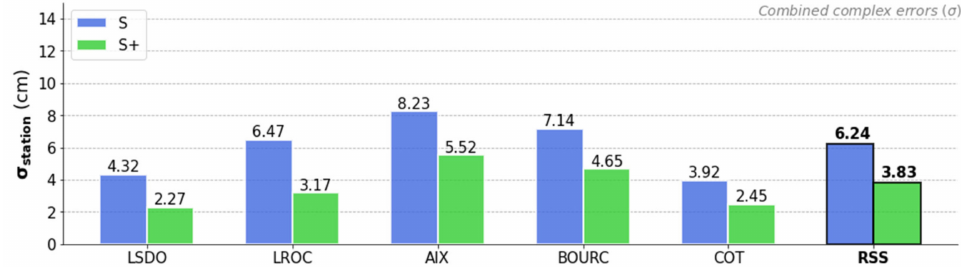
Figure 6. Combined complex errors of S (blue) and S+ (green) configurations, for 13 constituents at the 5 stations. The last bar chart (right, in bold) represents the Root-Sum-Square (RSS), combining all sites and all constituents.